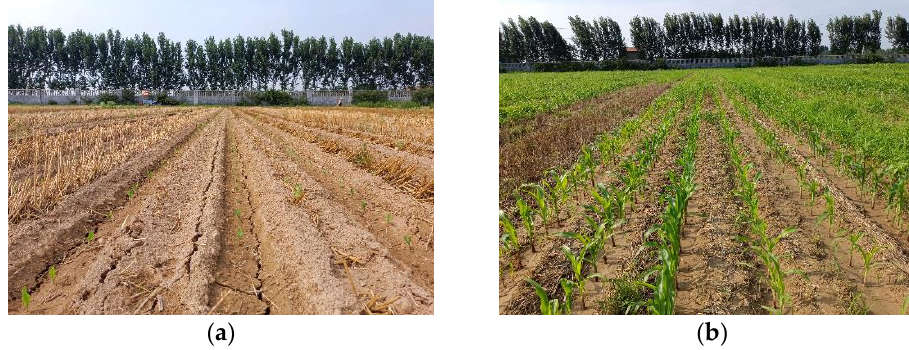
Figure 12. Maize emergence after the sowing in wheat straw covering filed. ( a ) Maize emergency,